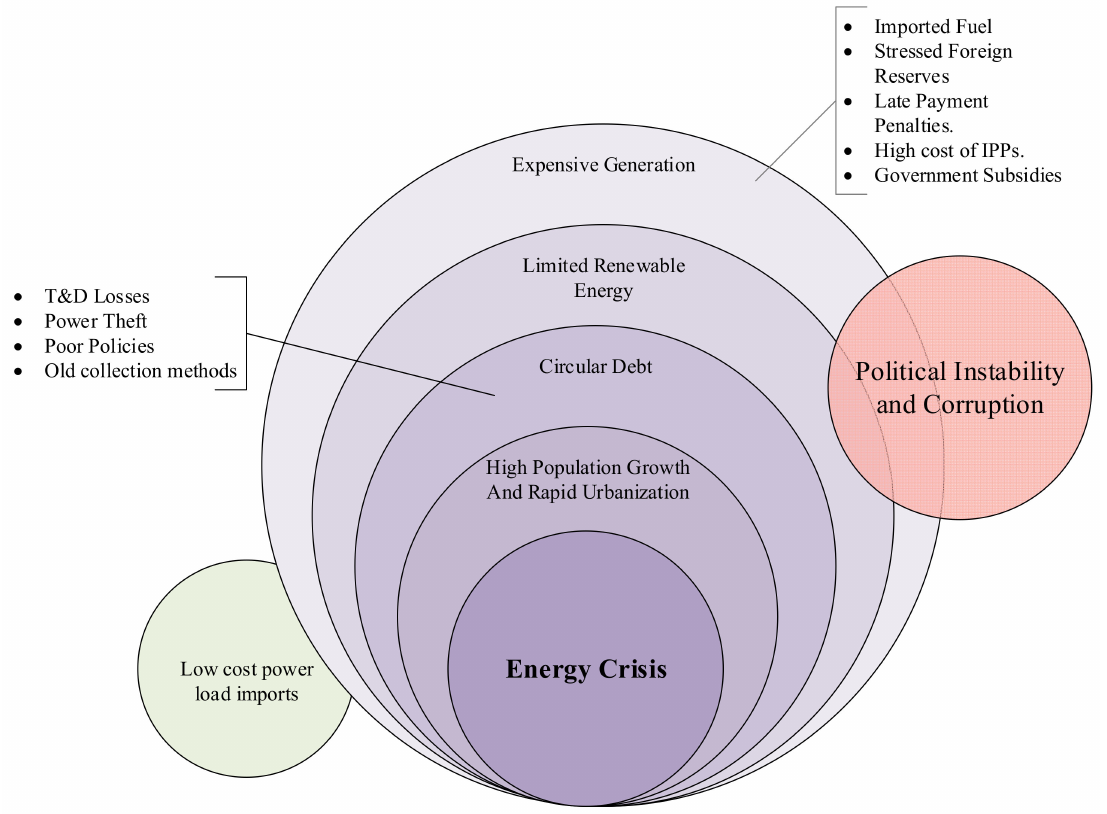
Figure 6. Energy crises in